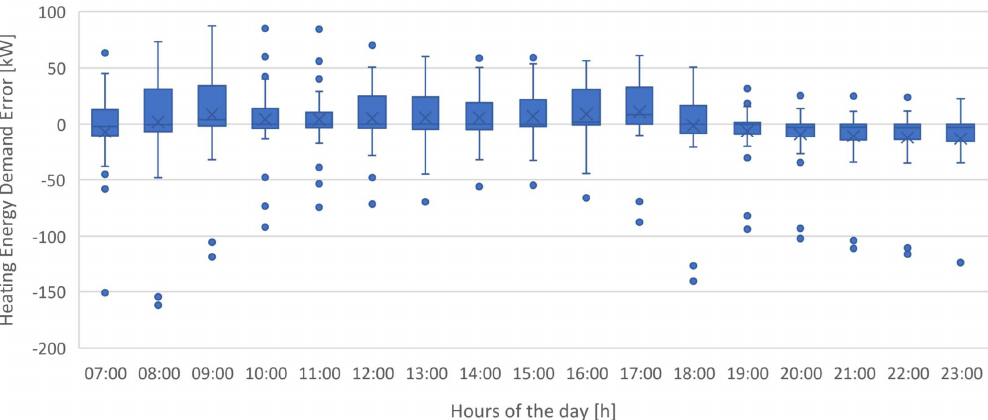
Figure 10. Heating energy demand error distribution during the test period using